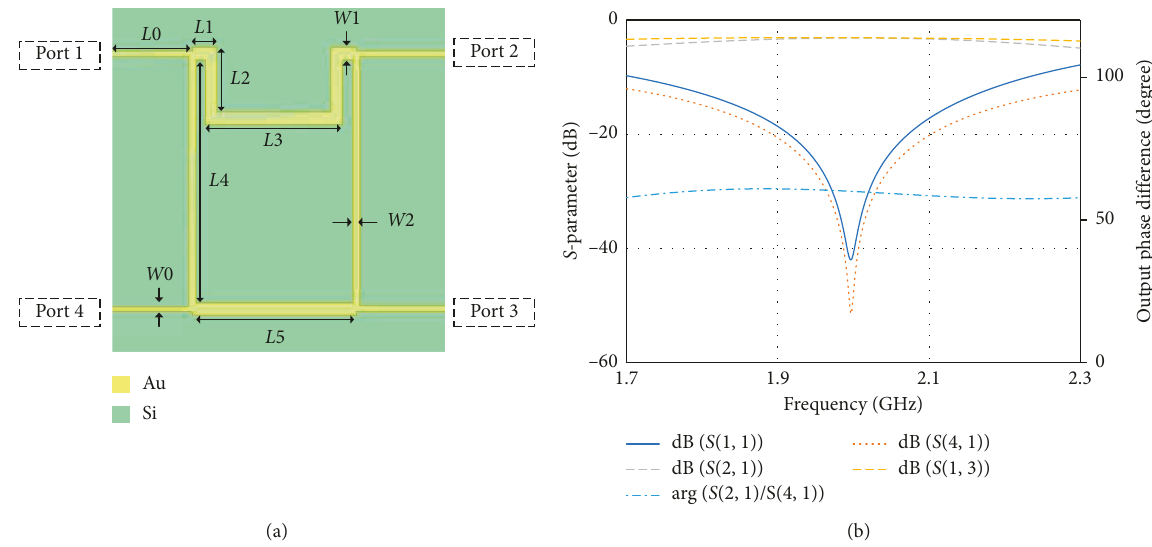
Figure 5: (a) Coupler model with 30 ° output phase difference. (b) Simulation of the coupler with 30 ° output phase difference.